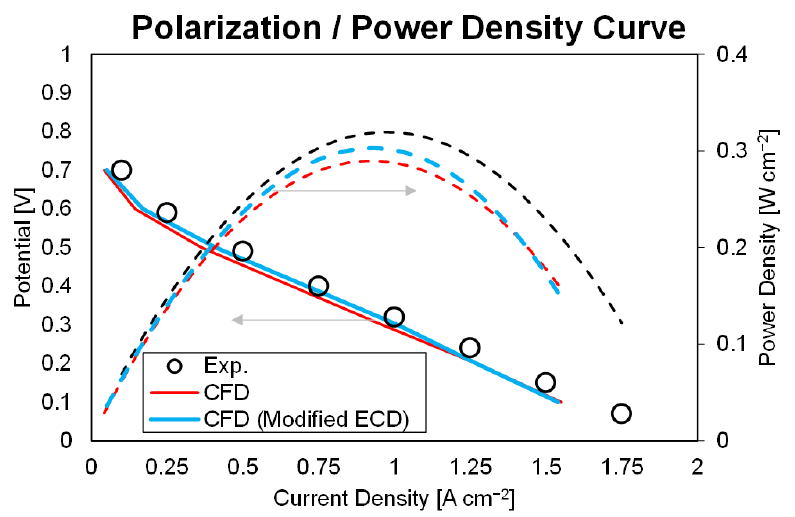
Figure 12. Polarization curve and electric power density for experiments and simulations, including the results using the improved exchange current density formulation (Equation (27)).